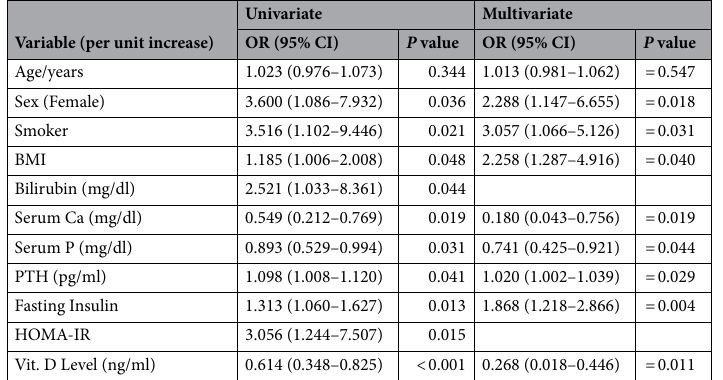
Table 6. Predictors of Osteoporosis among the NAFLD Sample: Logistic Regression Model. OR odd ratio, CI confidence interval.